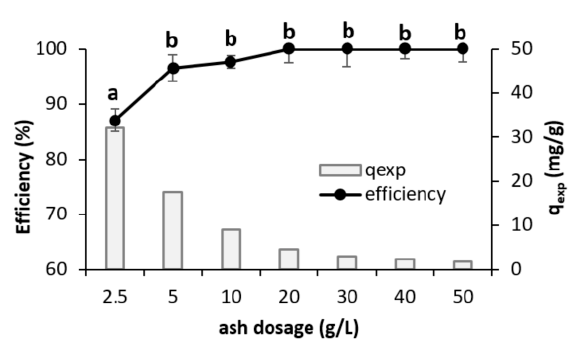
Figure 7. Efficiency of Cd adsorption and adsorption capacity as functions of ash dosage (Cd concentration = 100 mg/L, adsorption time = 24 h, pH 5). Error bars represent standard deviations ( n = 3). Different letters above bars indicate significantly different efficiencies with different ash dosages (ANOVA followed by Tukey’s honest significant difference test, p < 0.05).